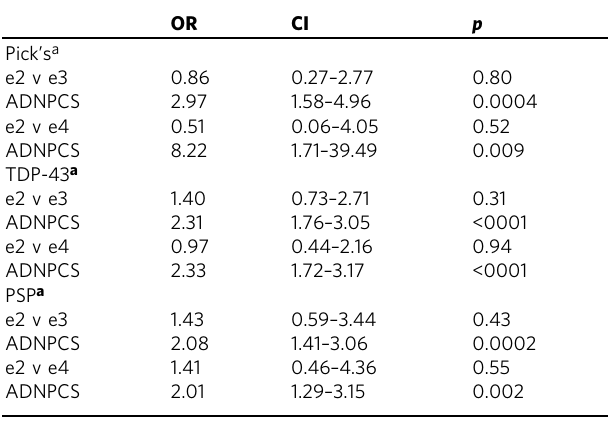
Table 4 Odds ratios for APOE e2 in fully adjusted models that included age at death, sex, and ad abc neuropathological change scores (shown as